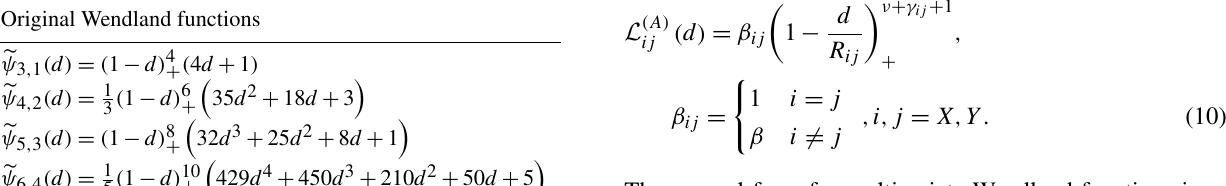
Table 1. Selected univariate Wendland functions. Original Wendland